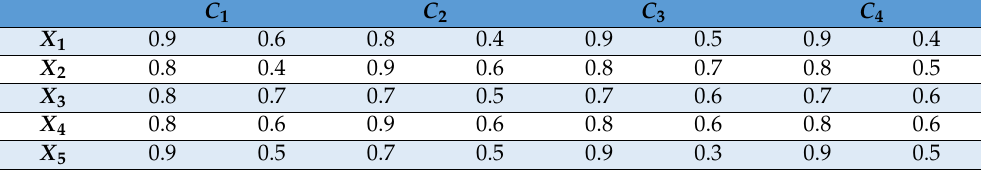
Table 3. Expert e 2 about energy resources under the given criteria. C 1